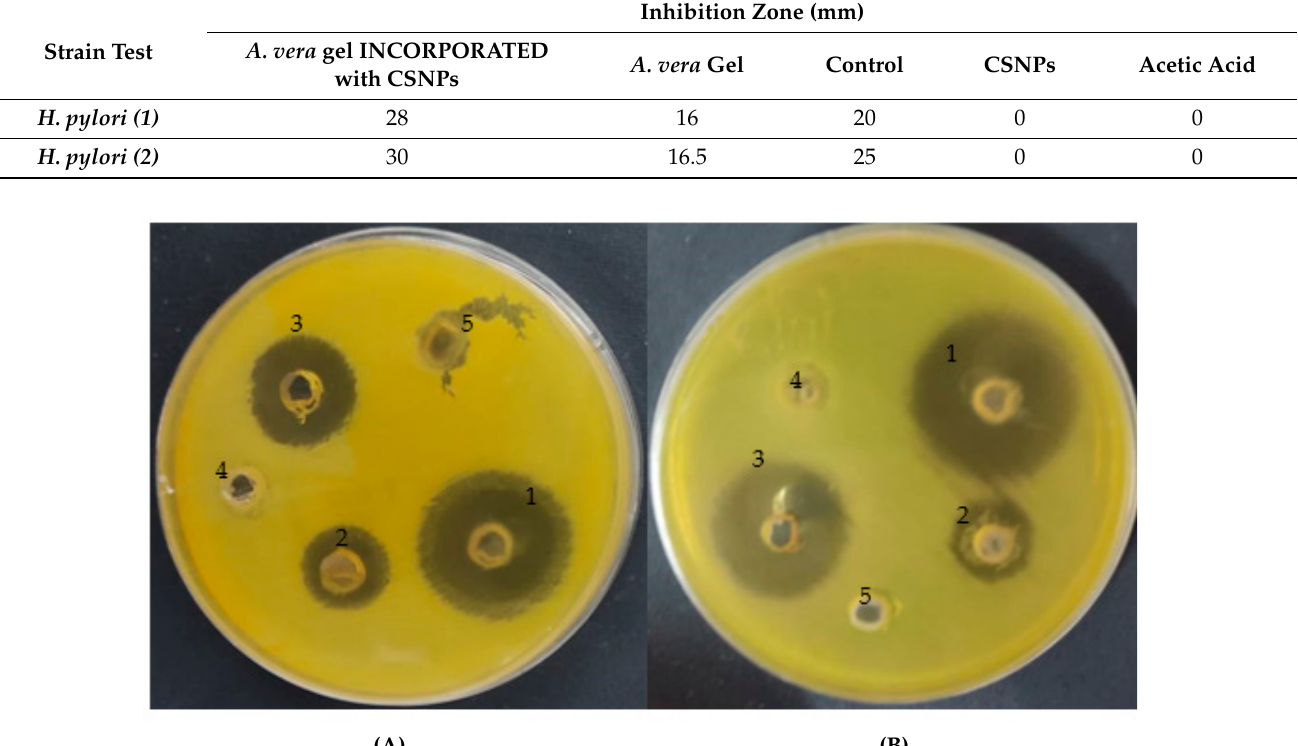
Figure 8. Inhibitory action of A. vera gel incorporated with CSNPs (1), A. vera gel (2), positive control (3), CSNPs (4), and acetic acid (5) against resistant strain ( A ) and sensitive strain ( B ) of Helicobacter pylori . Table 3. MIC and MBC of A. vera gel and A. vera gel incorporated with CSNPs against resistance strain of H. pylori